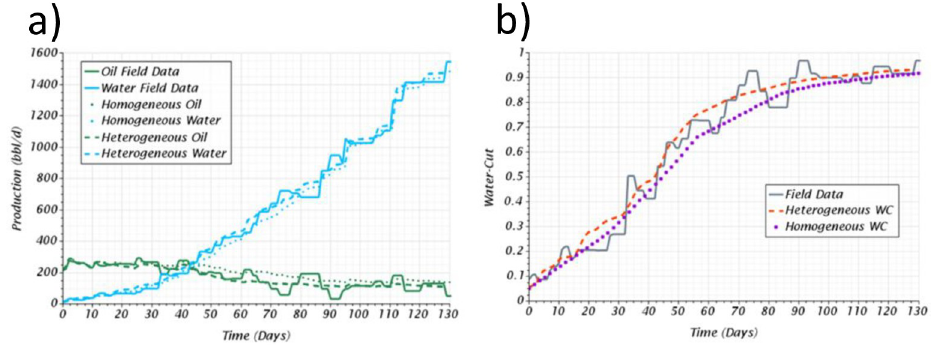
Fig 14. Results of the history match for the homogeneous and heterogeneous case, a) comparison against the reported oil and water production, b) comparison against the reported water-cut.